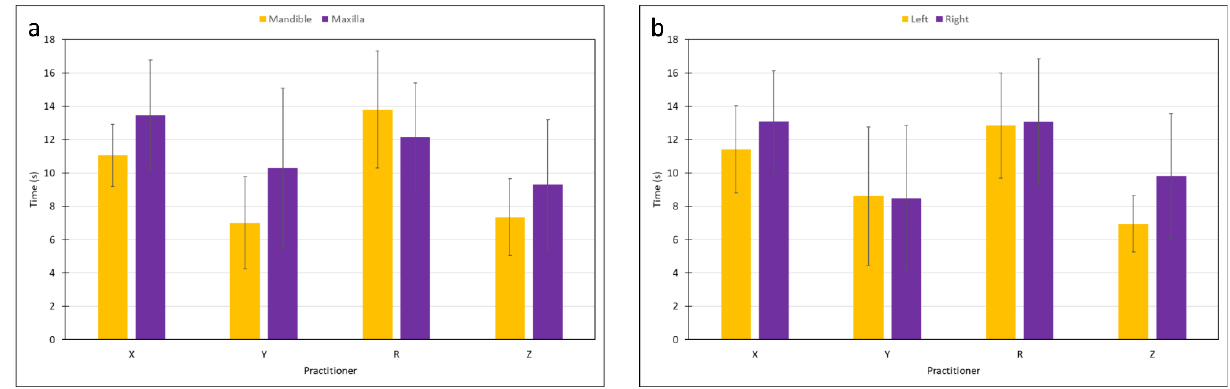
Figure 5. Restoration placement application time as related to practitioner and ( a ) jaw, ( b ) side.